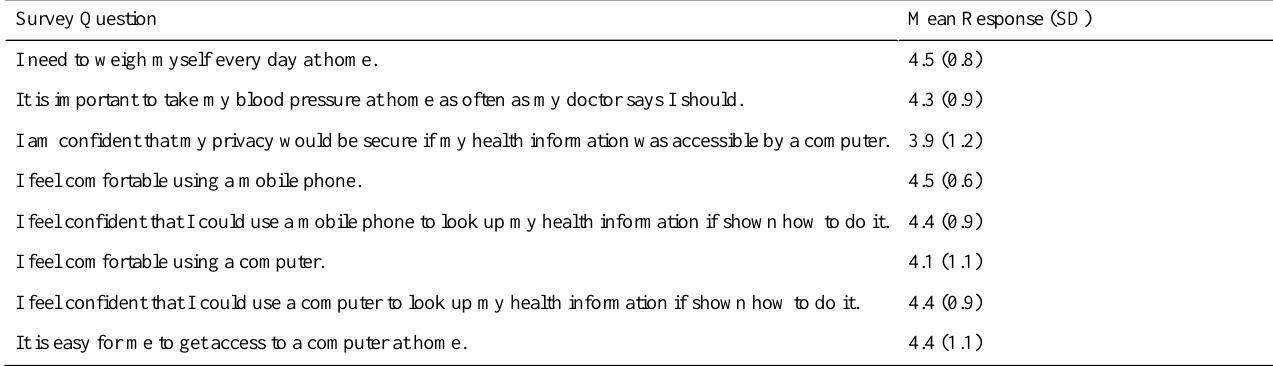
Table 2. Mean responses to survey questions (1: Strongly Disagree, 2: Disagree, 3: Neither Agree or Disagree, 4: Agree, 5: Strongly